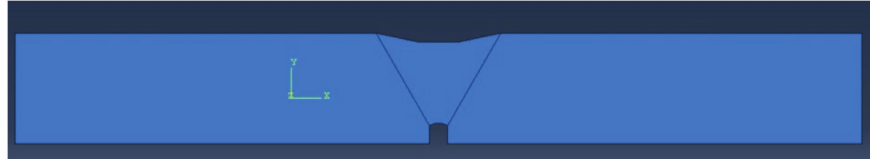
Figure 3. Weld metal sagging and incomplete root penetration.